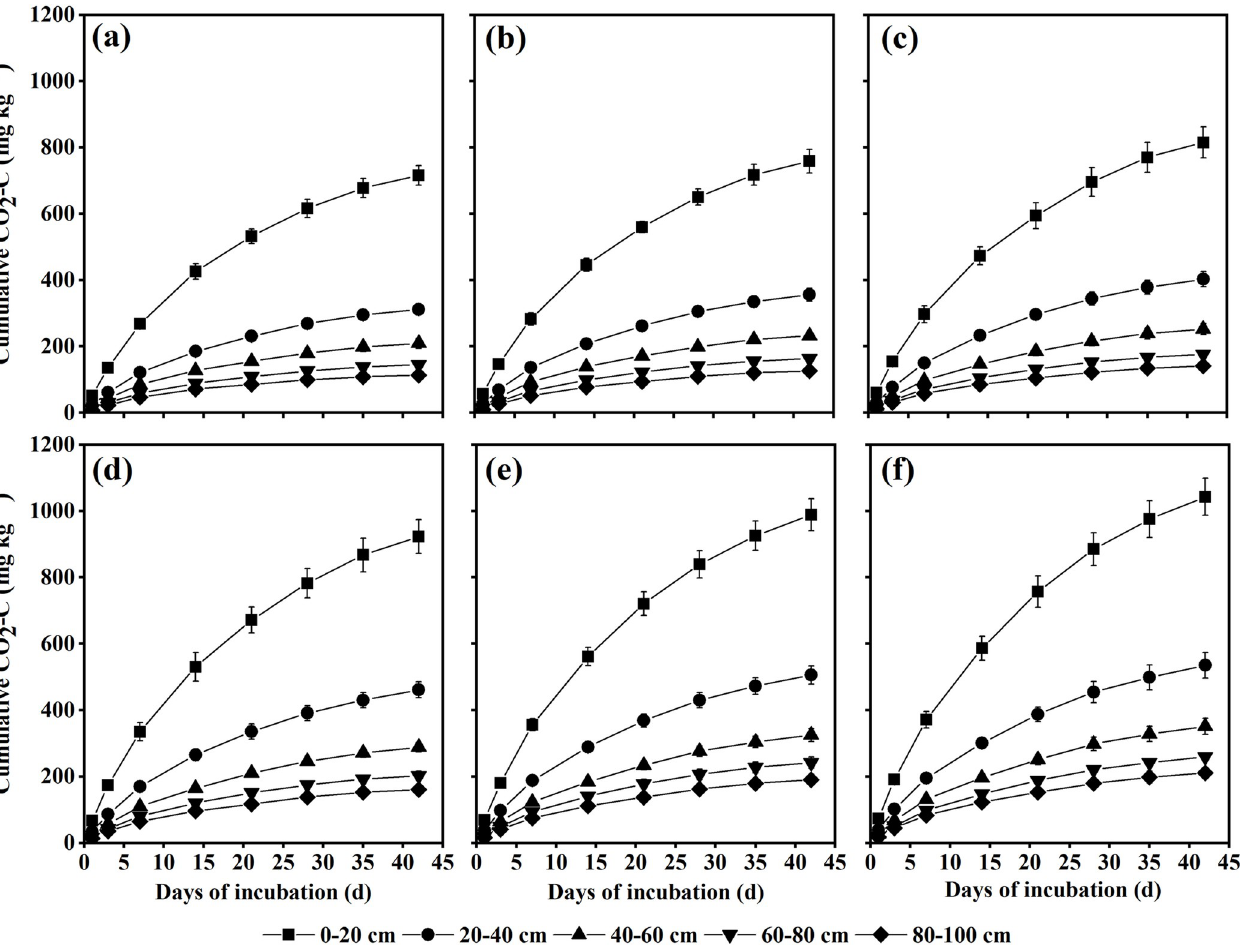
Fig 1. Cumulative CO 2 released process (mg CO 2 -C kg − 1 soil) from Z . bungeanum plantations in Arid Valley in soils over the incubation period. (a): FL; (b): ZB8; (c): ZB15; (d): ZB20; (e): ZB28; (f): AL. Error bars represent standard deviations ( n = 3).